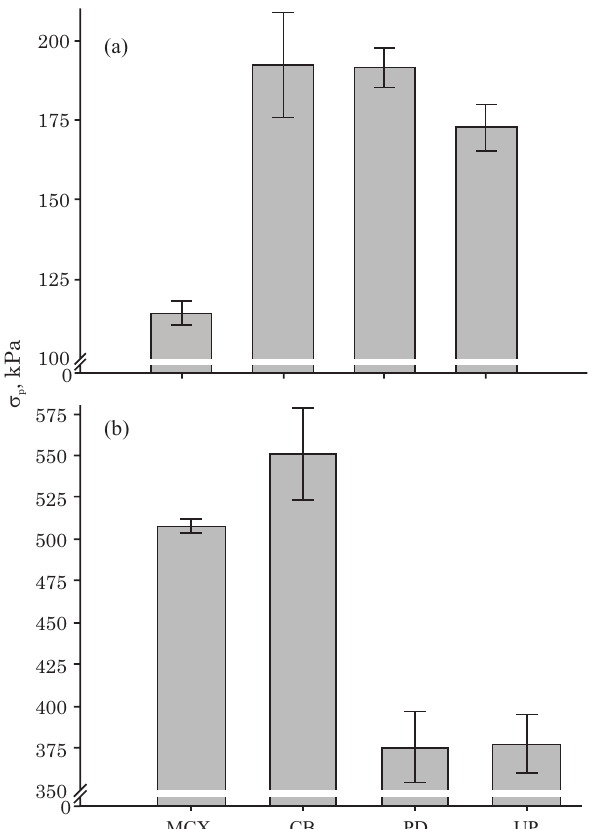
Figura 7. Médias da pressão de preconsolidação ( σσσσσ p ) equilibradas em alta umidade (a) e baixa umidade (b) para os diferentes tipos de uso em um Cambissolo Háplico. A barra de erros representa o erro-padrão da